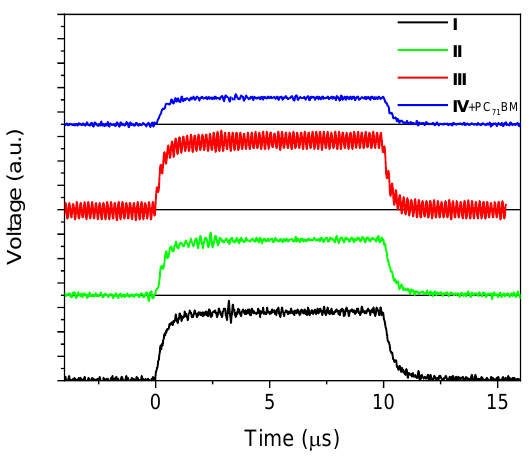
Figure 5. Photodetector transients (for details see the Materials and Methods Section).